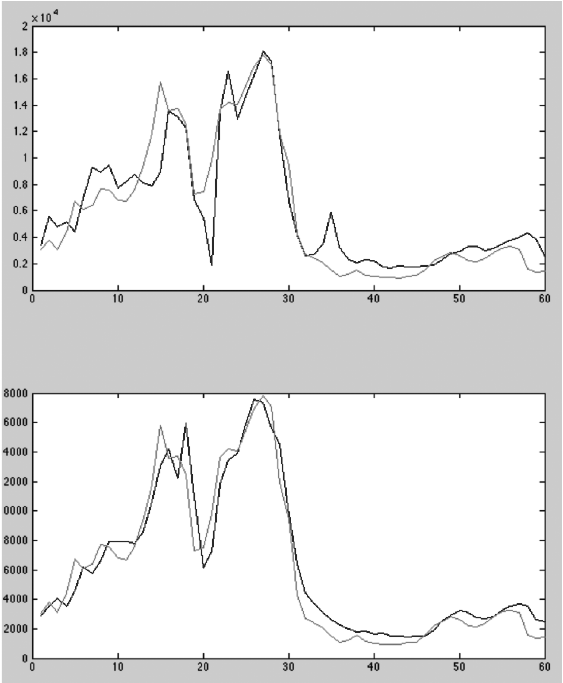
Fig. 2. Comparison of the prediction results of ANN (on top) and the proposed algorithm (bottom) (with data pre- processed using the Tukey53H